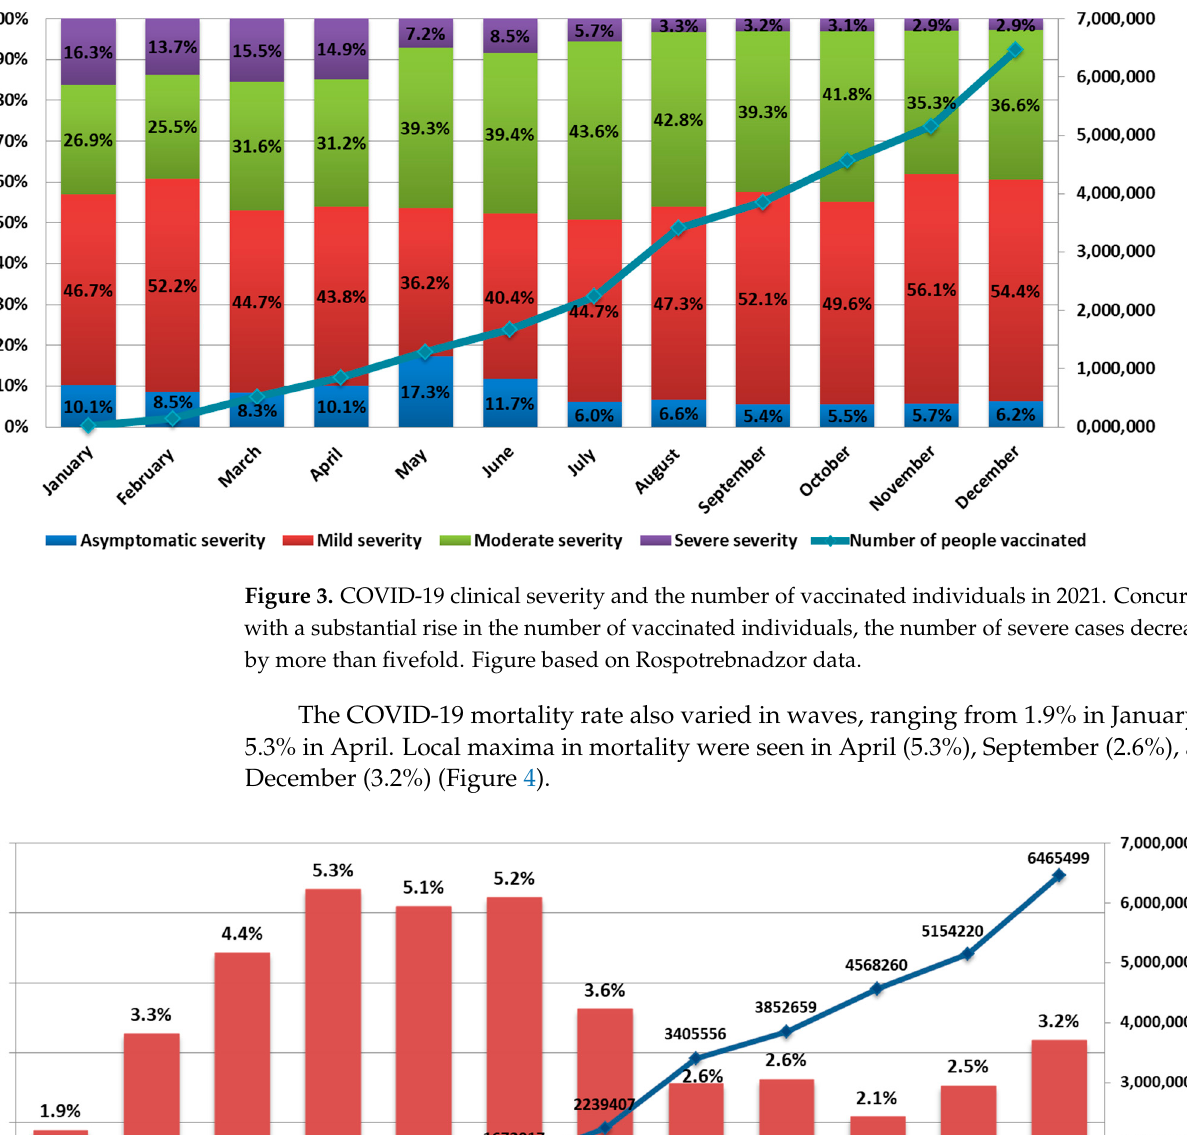
Figure 2. Changes in the demographic structure of COVID-19 incidence in 2021. The proportion of children among new COVID-19 cases increased twofold in 2021. Figure based on Rospotrebnadzor data.